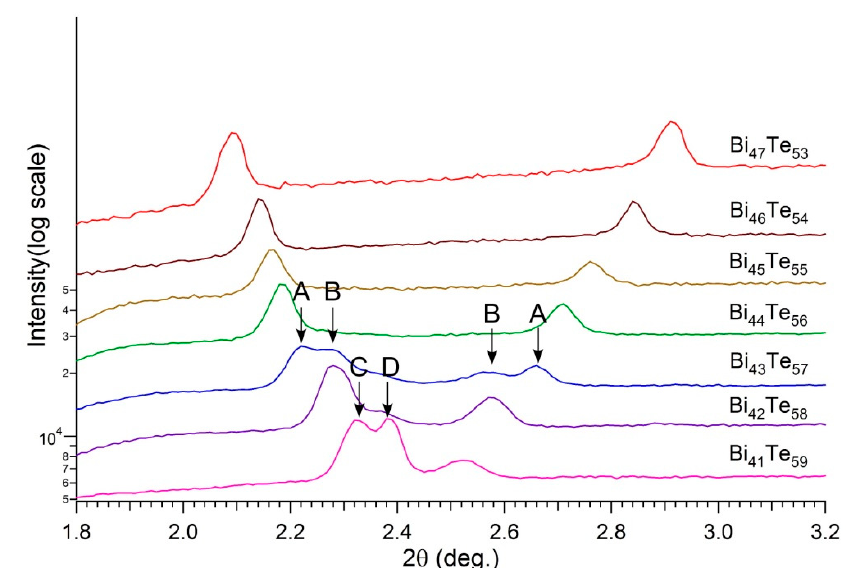
Figure 6. X-ray powder diffraction profiles of Bi–Te specimens acquired at 300 K. The horizontal axis has been enlarged, and the vertical axis is plotted with a logarithmic scale to emphasize the weaker peaks. The arrows indicate peak splitting due to phase separation: A, B, C, and D correspond to reflections from the Bi 4 Te 5 , Bi 3 Te 4 , Bi 13 Te 18 , and Bi 2 Te 3 phases, respectively.